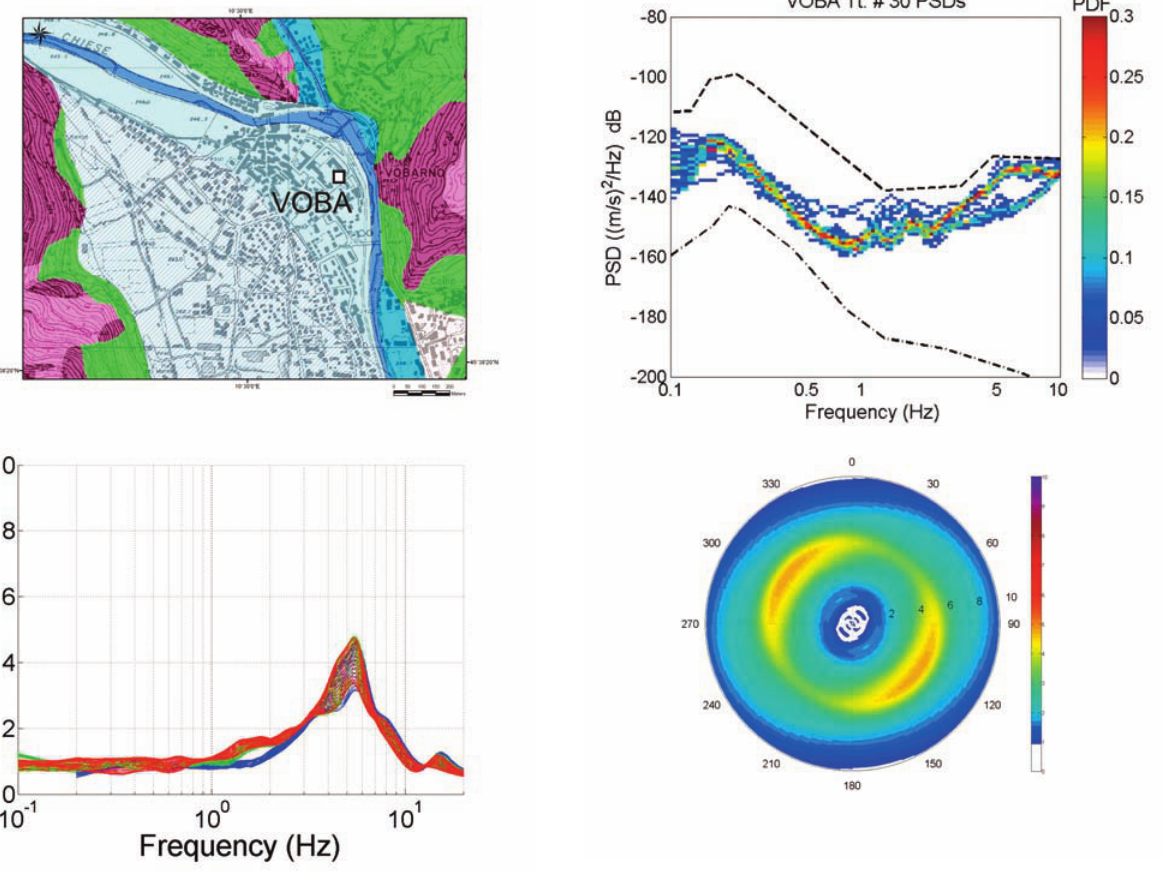
Figure 4. Site characterization of VOBA station (NTC08 B lithological class, see also Table 1). Top left: geological map (1:25,000 scale). Top right: probability density function of power spectral density performed on seismic noise. Bottom left: horizontal-to-vertical spectral ratio performed considering recorded earthquakes (different colors indicate different portions of the S-phase). Bottom right: frequency-azimuth polar plot (third dimension indicates value of amplification